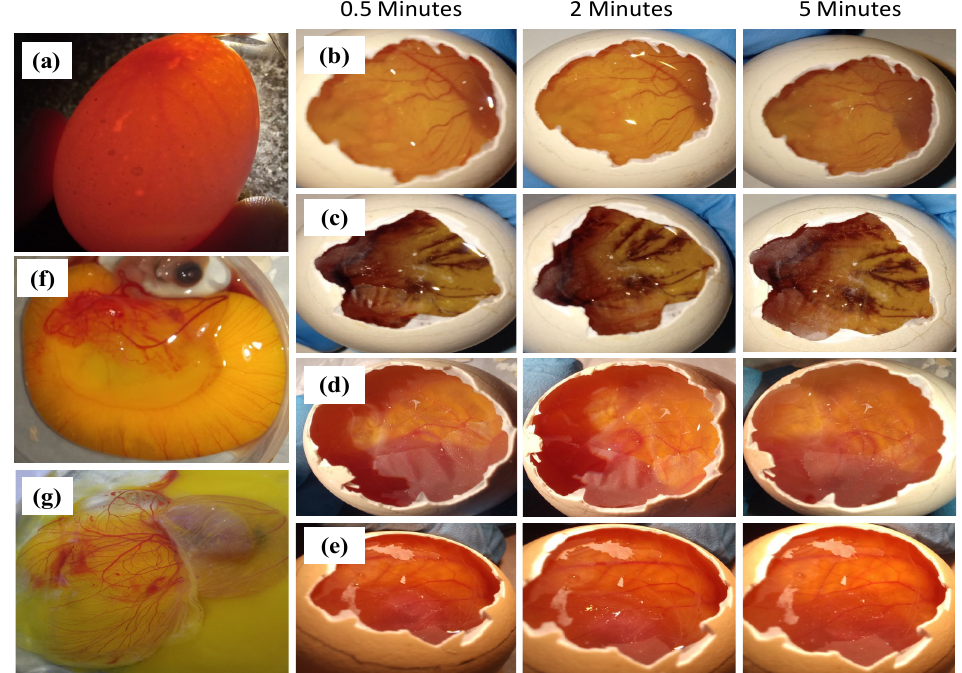
Figure 10. Pictures of HET-CAM Assay ( a ) candling of egg, CAM treated with ( b ) 0.9% w/v NaCl solution, ( c ) 0.1 N NaOH, ( d ) VCZ-MA-NPs, ( e ) VCZ-MP-NPs, and pictures of embryo after breaking internal membrane ( f ) VCZ-MA-NPs, ( g ) VCZ-MP-NPs.